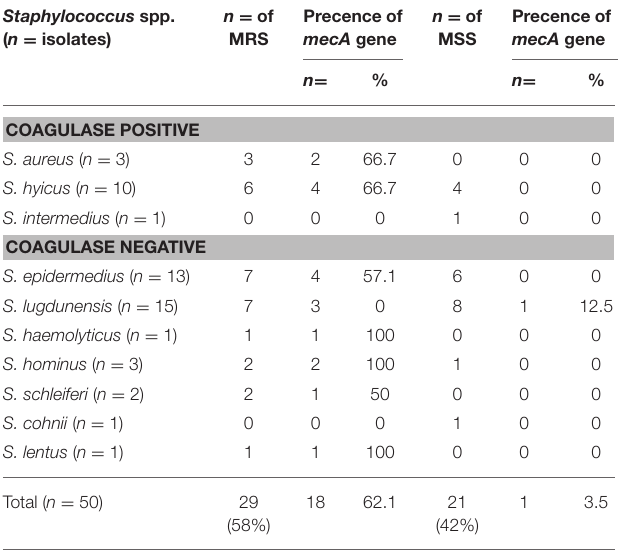
TABLE 5 | Prevalence of mecA gene in chicken meat